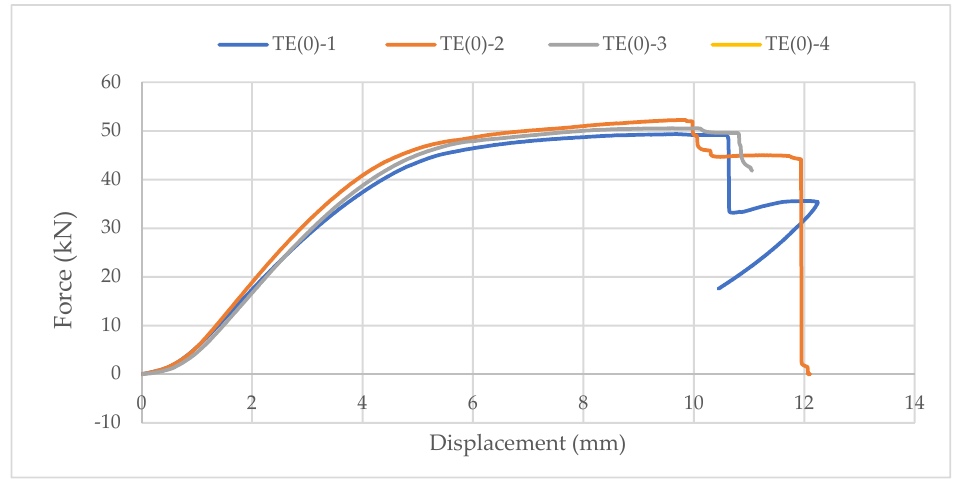
Figure 19. The force-displacement curve for compression perpendicular to the grain of samples with elliptical cavities in the direction of the weaker axis.